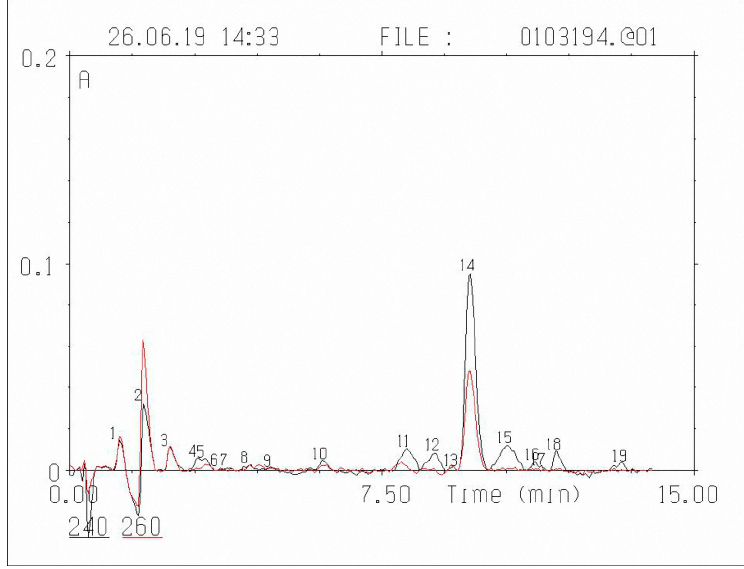
Figure 3. Chromatogram of rat blood plasma extract: the black line refers to absorption at 240 nm, the red line is absorption at 260 nm; N12 - 11-dehydrocorticosterone; N14 – corticosterone.